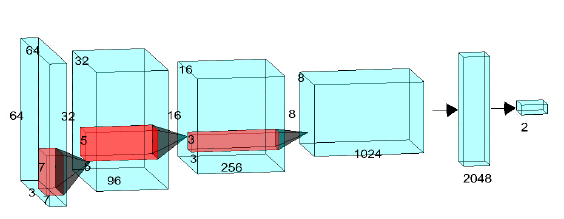
Figure 8. Schematic diagram of the crack detection neural network. Table 3. The details of the structure of the crack detection neural network.